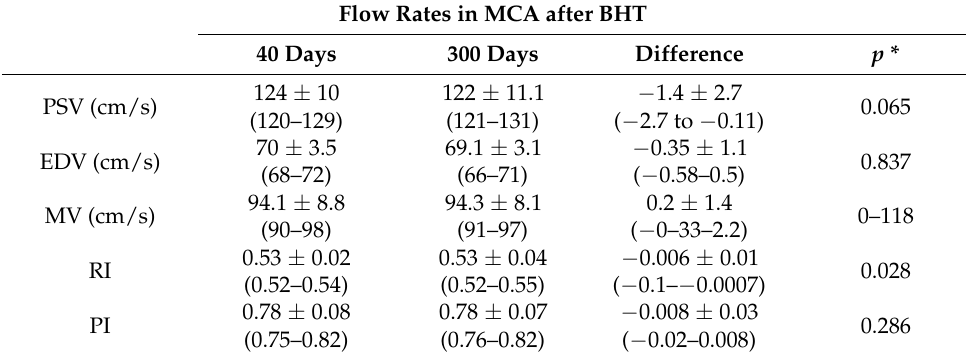
Table 9. Arithmetic means of MCA flow rates ± SD (95% CI) after a BHT 40 days and 300 days from the onset of